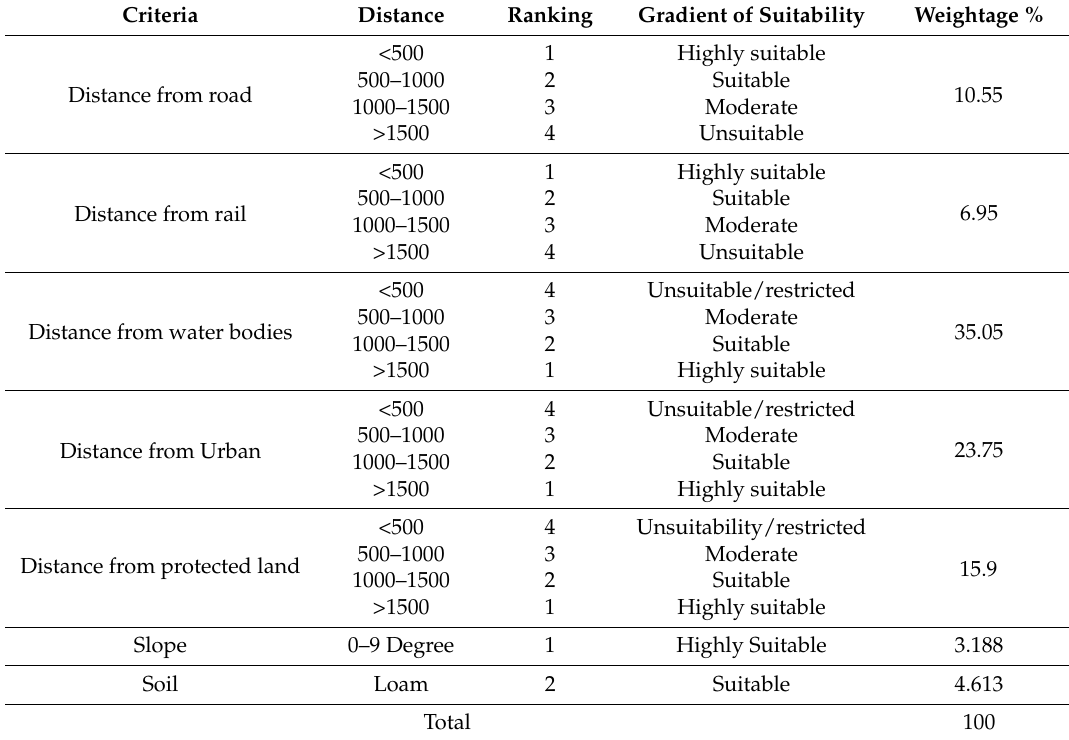
Table 2. Weightage of factors influencing the suitability of landfill